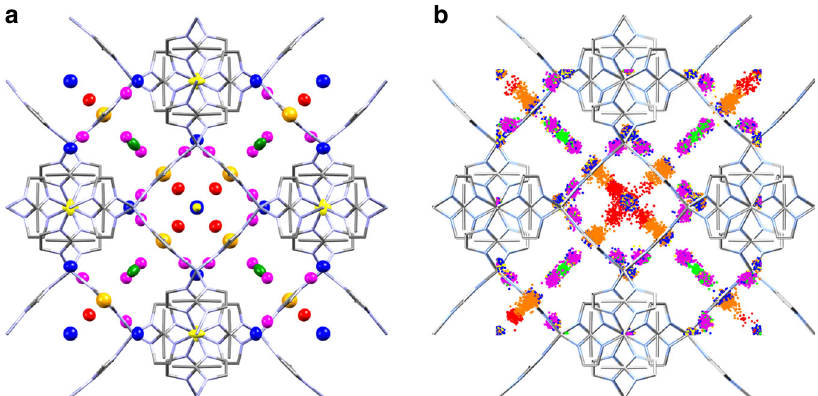
Fig. 3 Comparison of Ar adsorption sites in ZIF-8-HP. a 1.20 GPa (298 K) crystal structure and b GCMC simulations at 100 kPa (at 83 K) of Ar. Colour scheme; Zn (light grey), N (light blue) and C (grey). Hydrogen atoms have been omitted for clarity. In a and b framework atoms are drawn as capped sticks, while Ar atoms are coloured according to the six symmetry-independent sites. In a Ar atoms are drawn with anisotropic displacement parameters (50% probability), while in b Ar atoms are shown as the binned positions with their relative energies from the GCMC